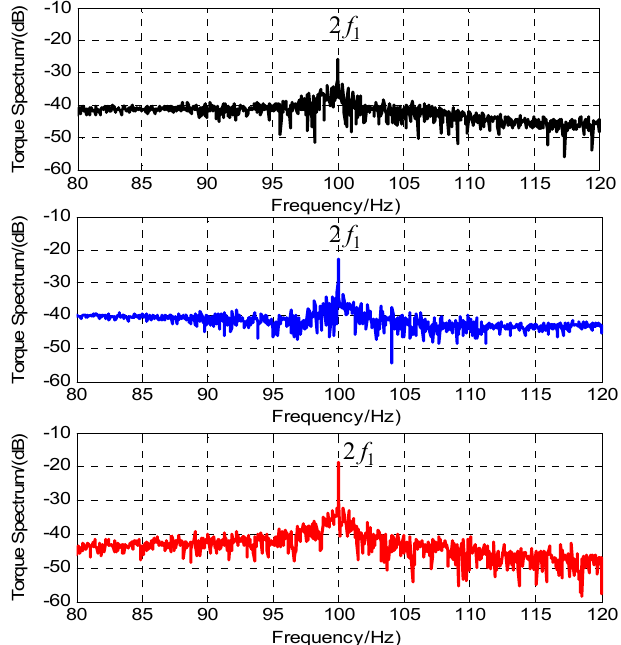
Figure 20. Torque spectrum under stator faults (top: health, middle: R f = 2.435 Ω , bottom: R f = 0.2314 Ω ).